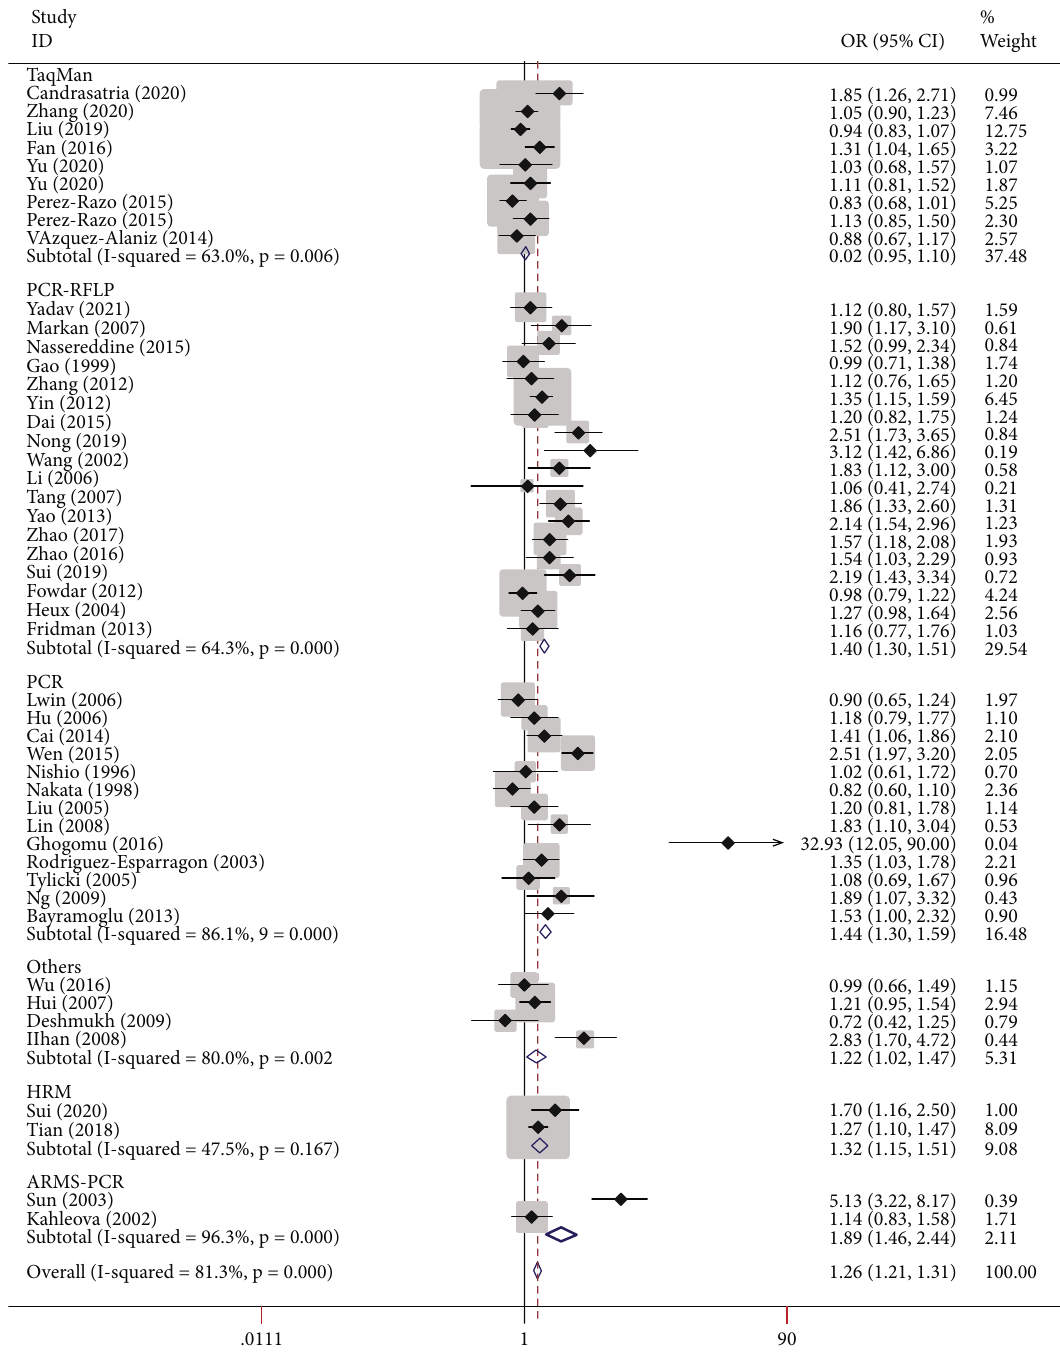
Figure 8: T-allele frequencies for the MTHFR gene rs1801133 polymorphism among cases/controls strati fi ed by subgroups in T-allele vs. C- allele model in genotype method subgroup by fi xed e ff ect